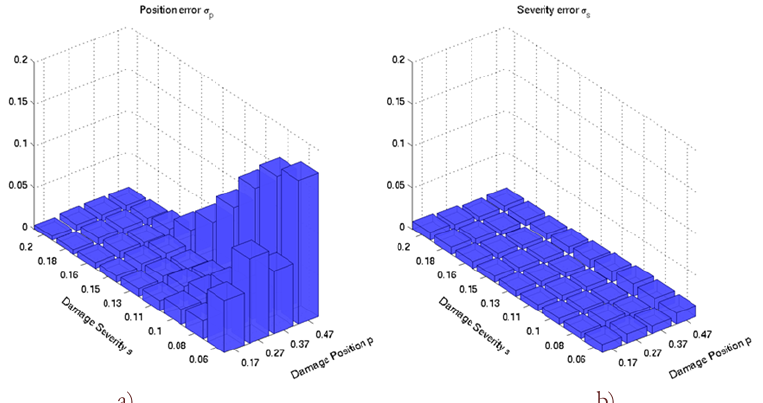
Figure 4: Standard deviation of the errors on the identified damage as the damage position and the severity changes for a 15% Gaussian random error on the measured harmonics. a) Standard deviation of the position error; b) Standard deviation of the severity